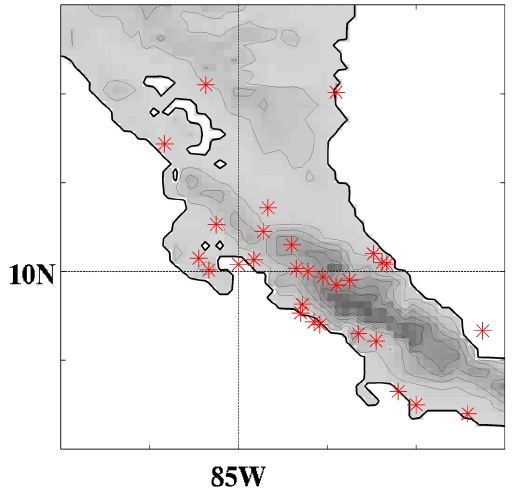
Fig. 1. Red asterisks represent the positions of the stations used. Contours associated with 0, 300, 700, 1100, 1500, 1900 and 3000m topographic levels were